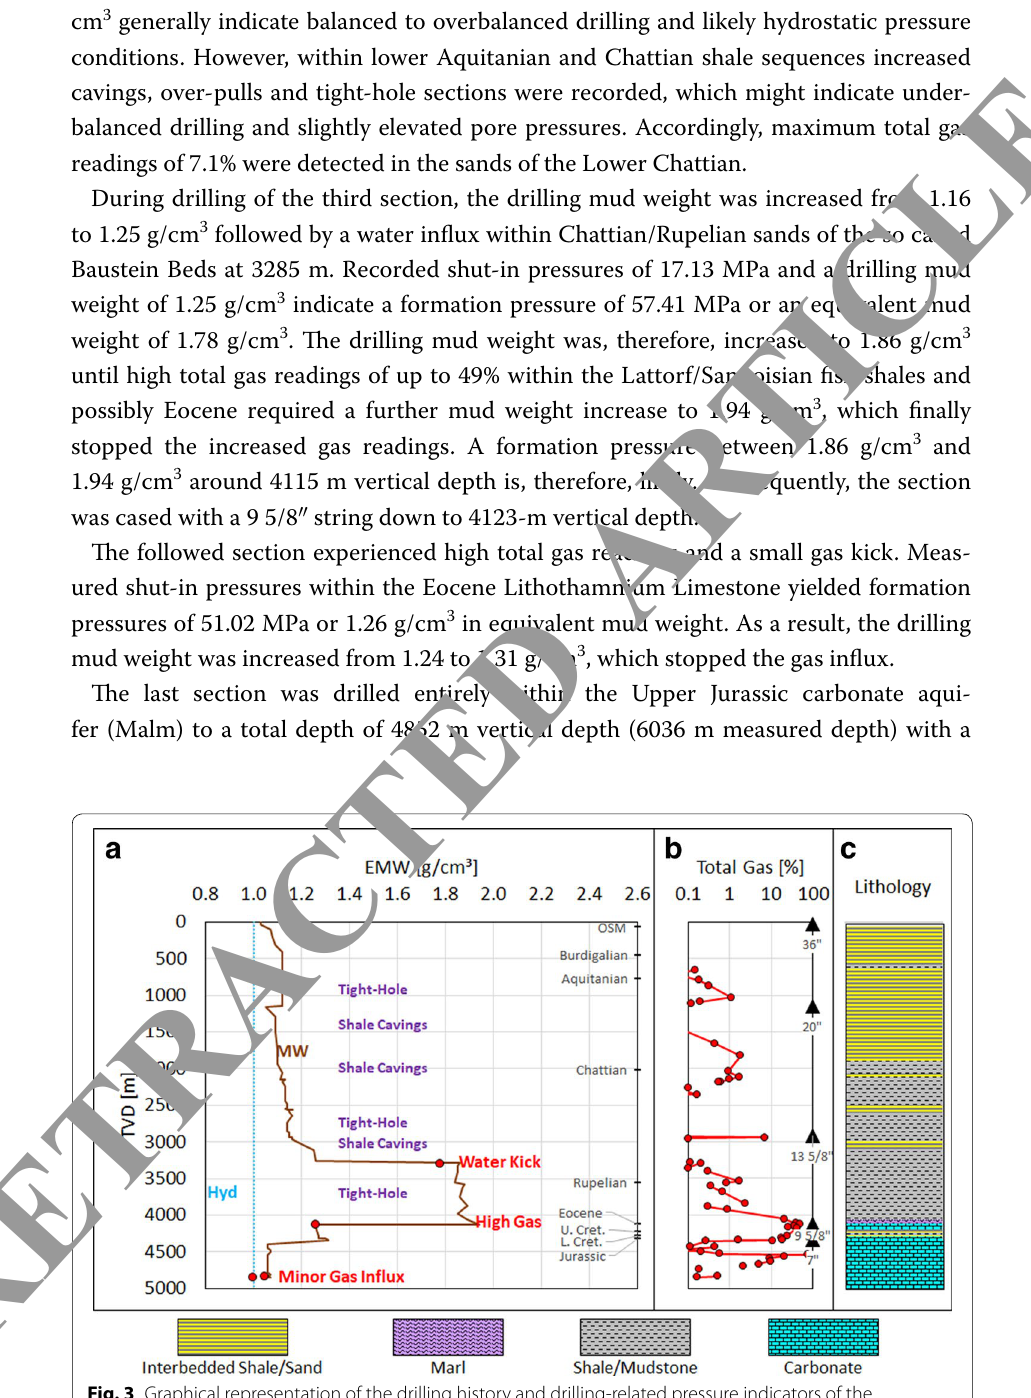
Fig. 3 Graphical representation of the drilling history and drilling-related pressure indicators of the Geretsried GEN-1 well. a Pressure in equivalent mud weight (EMW) in g/cm 3 vs. true vertical depth (TVD) with drilling mud weight MW (brown line), hydrostatic pressure Hyd (blue-dotted line), influx events (red dots and annotations), other overpressure indications (purple annotations) and stratigraphic tops. b Total gas readings while drilling on a logarithmic scale in percent (red lines and dots) and casing points (black triangles). c Simplified lithological profile based on cutting descriptions from the geological well report (legend on the bottom provides key for